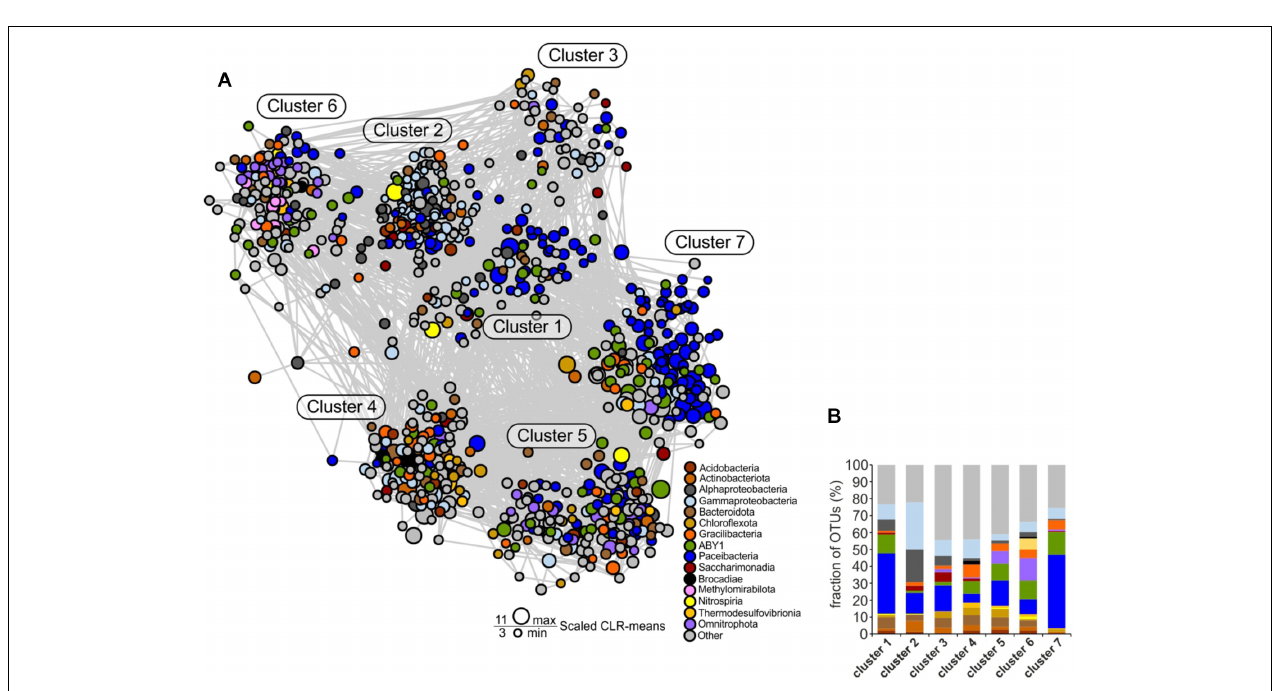
FIGURE 7 | Co-occurrence network of species-level OTUs across the two aquifer assemblages. For each sample, data sets from the 0.2 and 0.1 µ m filter size fraction were merged. Only significant edges are displayed. (A) Co-occurrence network. Construction was based on a centered log-ratio (CLR) transformed OTU table and Meinshausen-Bühlmann neighborhood selection as graphical inference model. (B) Detailed view of the relative fraction of taxonomic groups across the seven clusters of the network.